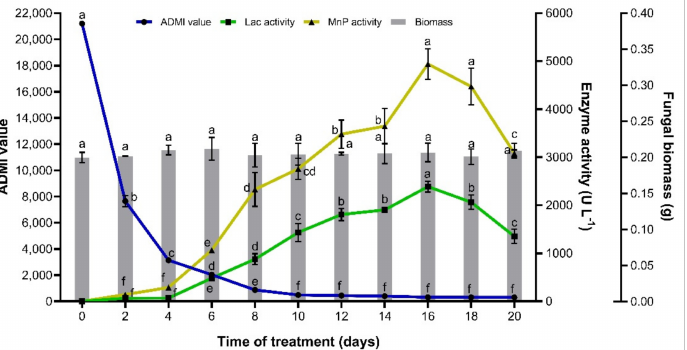
Figure 6. A time course study of textile dye decolourisation and MnP and laccase production by immobilised T. hirsuta PW17-41 under a submerged cultivation condition using 33% ( v/v ) dye concentration (or 21,200 ADMI) at 30 ◦ C and 100 rpm for 20 days. Error bars indicate standard deviation and letters a–g indicate statistically significant differences between groups analysed via one-way ANOVA ( n = 3, p <